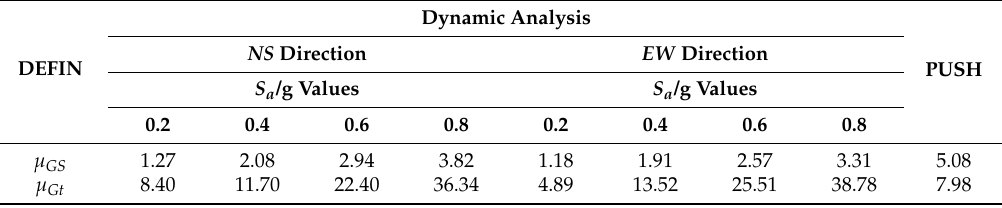
Table 9. Global ductility ( µ GS y µ Gt ), 10-level